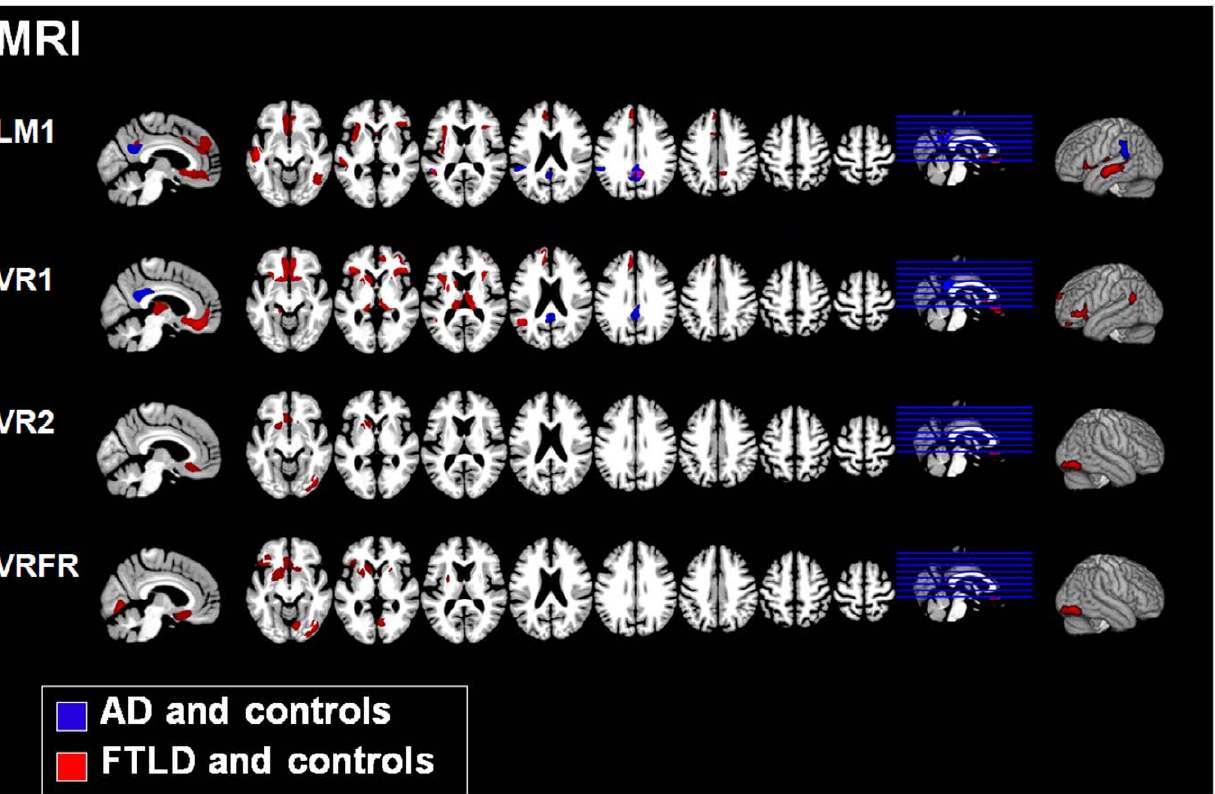
Figure 3. Memory performance and atrophy. Correlations between atrophy (MRI) and each memory measure for AD patients and controls (blue) as well as FTLD patients and controls (red). Areas of overlap are shown in violet (in LM1 only). LM: WMS Logical Memory , VR: WMS Visual Reproduction , 1: immediate recall, 2: delayed recall, FR: Forgetting rate. Results are only reported for those memory measures for which significant correlations in any region were found. Only clusters are shown that exceeded a significance threshold of p , 0.001 uncorrected at voxel level and a cluster threshold of 2000 voxels. Left is left.